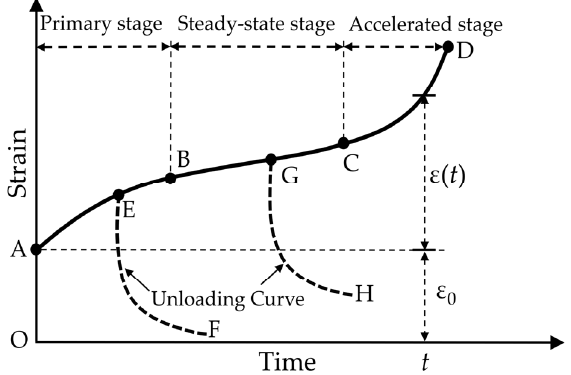
Figure 4. Typical rock creep curve, where AB is the primary creep stage, BC is the steady-state creep stage, CD is the accelerated creep stage, EF is the unloading curve during the primary creep stage, GH is the unloading curve during the steady-state creep stage, ε 0 is the instantaneous strain and ε ( t ) is the creep strain at time t .